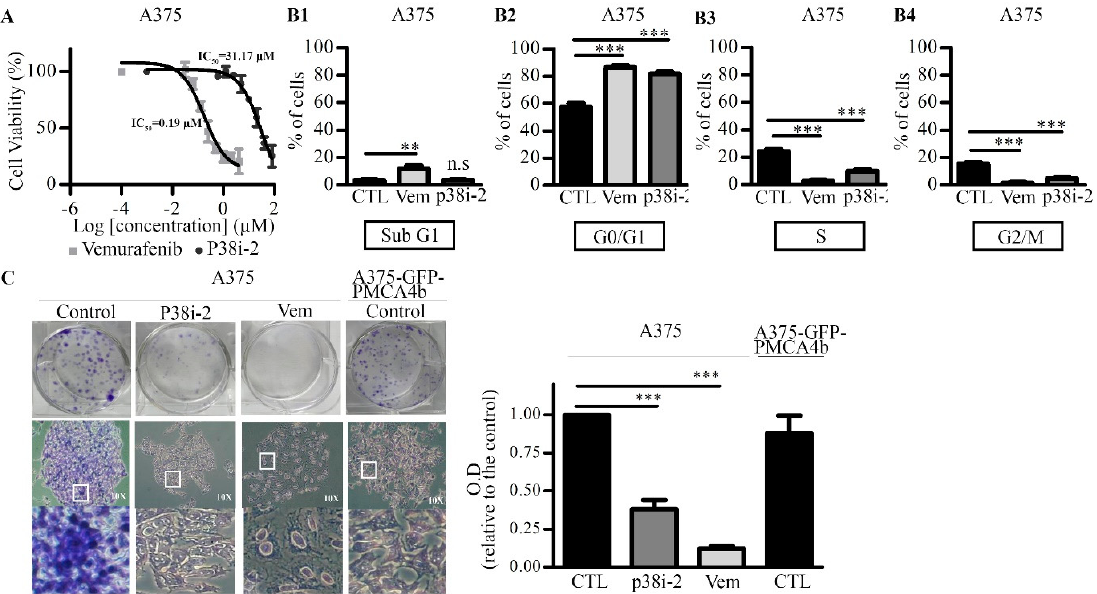
Figure 5. P38 inhibitor reduced proliferation and colony formation of A375 cells. ( A ) A375 cells were treated with vemurafenib or SB202190 inhibitors at increasing concentrations. After a 48-h incubation period cell viability was assessed by the SRB assay. ( B1 – 4 ) Cell cycle analysis was performed after 48-h 0.5 µ M vemurafenib or 10 µ M p38i-2 inhibitor (SB202190) treatments. Data are means ± SE of three independent experiments. ( C ) A375 and A375-GFP-PMCA4b cells were treated with 0.5 µ M vemurafenib or 10 µ M SB202190 for 7 days (media and treatments were changed on the fourth day). Cells were fixed and stained with 0.5% crystal violet. Data are means ± SD of three independent experiments.